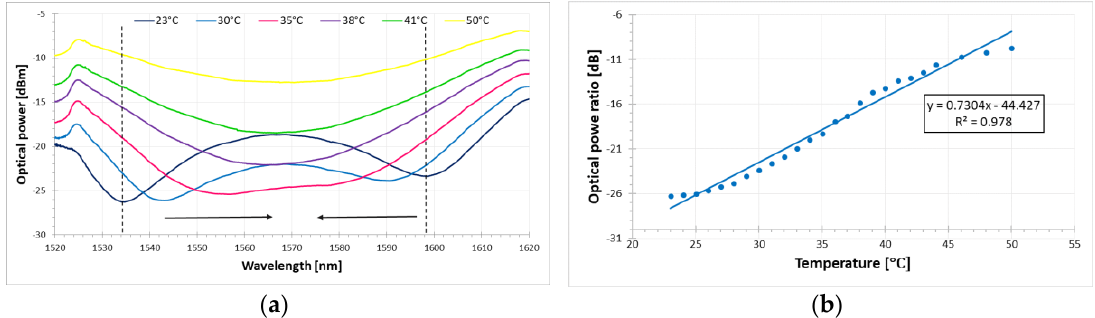
Figure 3. Transmission spectra of the DRLPG for ( a ) different temperatures in a liquid with RI value of n = 1.3333 and ( b ) optical power ratio between the two marked dashed line notches in figure ( a ) with a fitting linear function. The black arrows from ( a ) indicate the direction of the notches wavelength shifting.